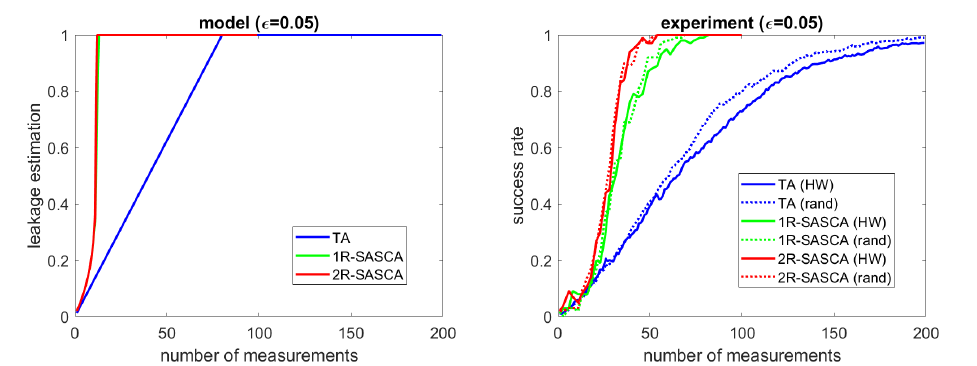
Figure 8: Leakage bounds and success rates of experimental SASCA with up to two rounds against an unprotected AES implementation in a known plaintext scenario (I).